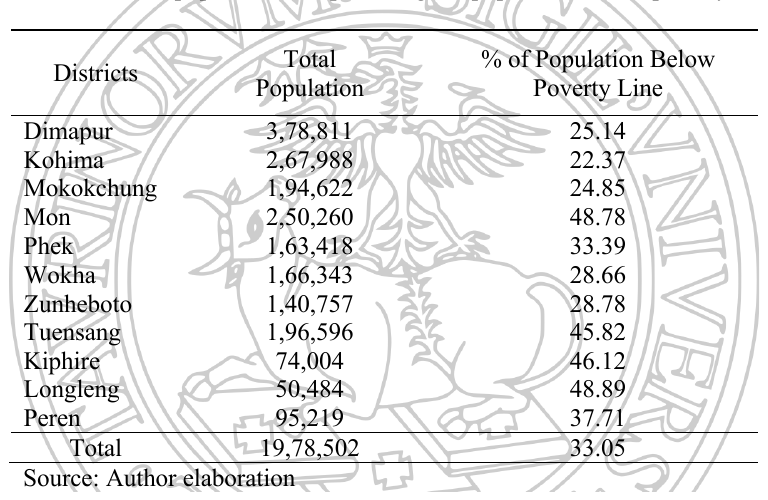
Table 2 : Total population and percentage of population below poverty line